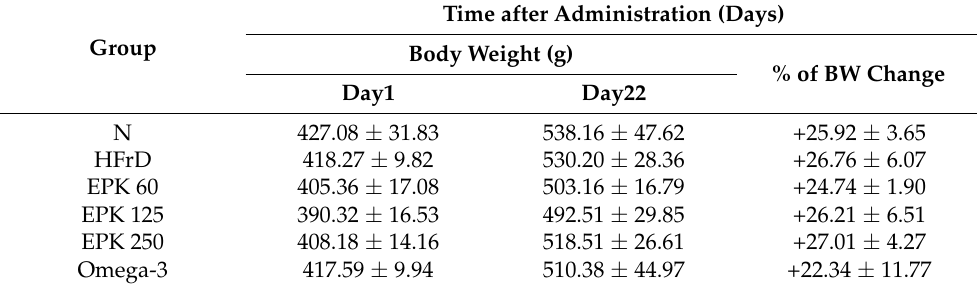
Table 2. Body weight in experimental groups.